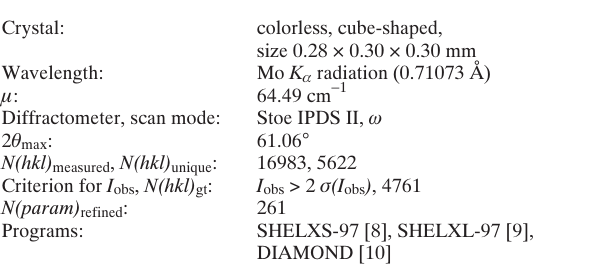
Table 1. Data collection and